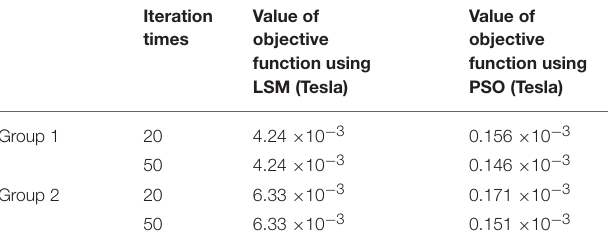
TABLE 3 | Comparison of the value of objective function using LSM and PSO.